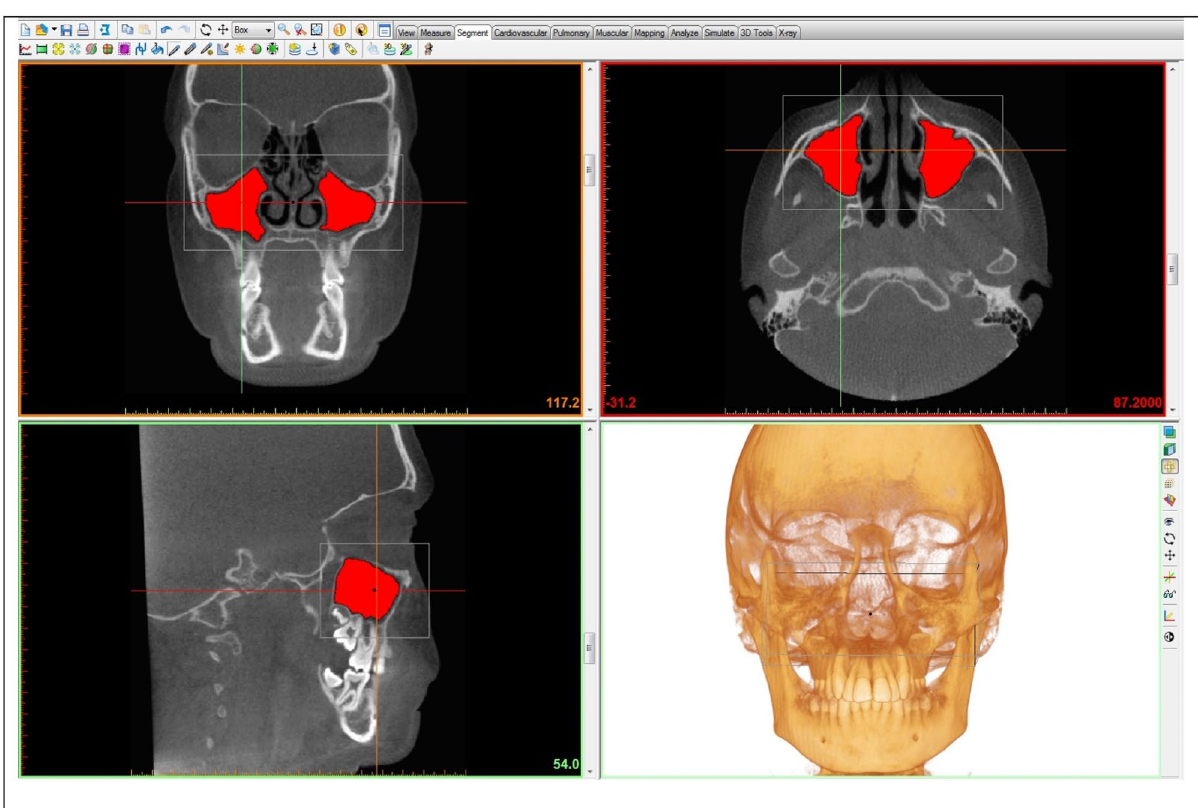
Figure 2. The region growing tool was used to separate and isolate MSs using Mimics Research™ v.16 software (NV, Technologielaan 15, 3001 Leuven, Belgium, https:// www. mater ialise. com/ en/ medic al/ mimics- innov ation- suite/